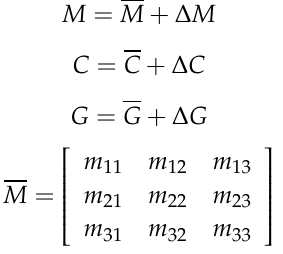
Figure 15. The sketch of a three DOF (Degree of Freedom) upper limb rehabilitation robot.